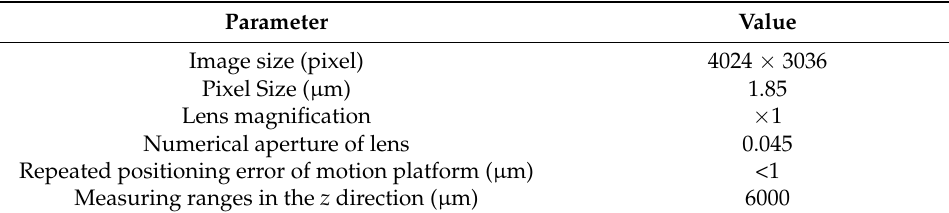
Figure 10. Shape from focus measurement system. Table 2. Parameters for the experimental platform.